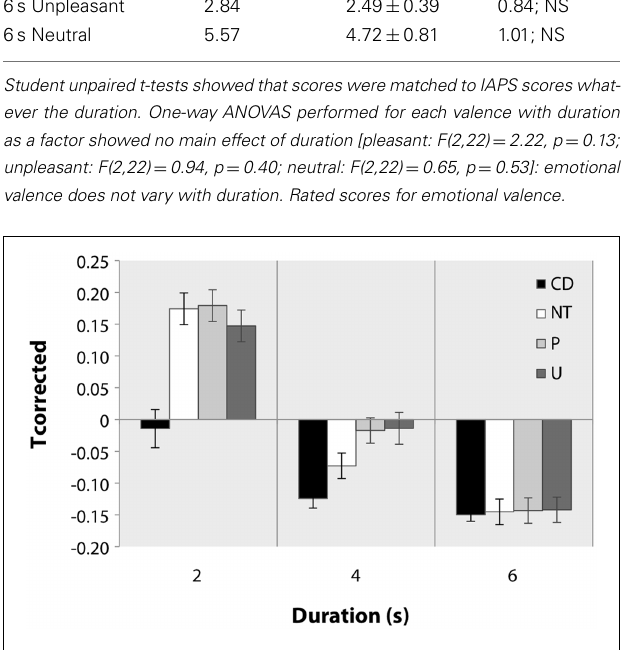
FIGURE 1 |T-corrected (averaged across participants) for each standard duration (2, 4, 6s) in content-deprived (CD), neutral (NT), pleasant (P), and unpleasant (U) conditions (error bars denote SR of the